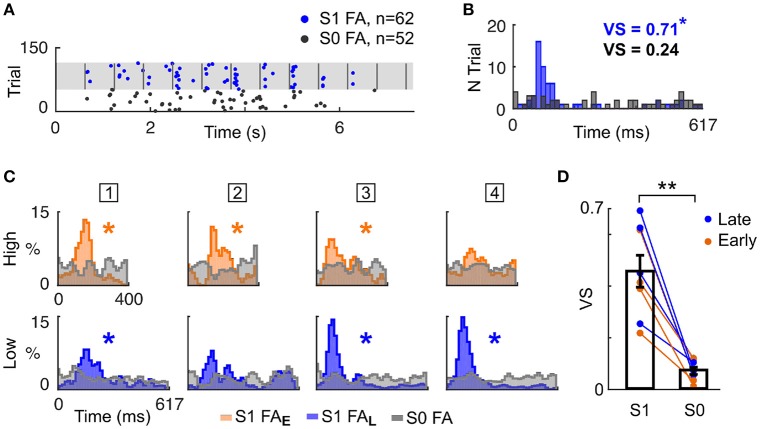
Mice timed their false alarm responses to tone onsets. (A) Example FA during the Late block in a single session. Each dot represents a FA response, in the S0 (grey) or S1 (blue) condition. Vertical grey lines indicate sound onsets in S1 condition. (B) FA reaction time (RT) distributions for S0 and S1 conditions (same colors as in A). The Vector Strength (VS) indicates the peak strength of the distribution, and is reported in the inset (*p < 0.05). (C). Normalised RT distribution for FA in S1 conditions for each mice (one mouse per column, the mouse ID is presented in the square box) computed using all sessions. RT are measured either from High (top) or Low (bottom) tone onsets. The distributions are color-coded based on the block type (Early or Late). The RT distribution of a mouse generating FA timed to sound onsets presents a peak, as assessed by the VS (*p < 0.05). RT distributions are smoothed (1 bin std Gaussian filter) for display. (D) The VS was significantly higher in the S1 than S0 condition. Each line indicates the VS change between S1 and S0 condition for a mouse generating FA in a specific block type (Early or Late). **P < 0.005.